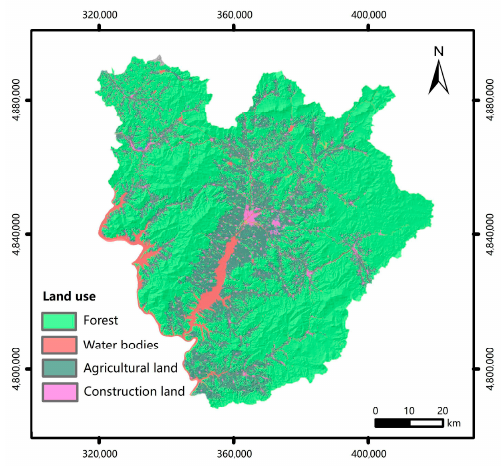
Figure 10. Land use of Jiaohe County